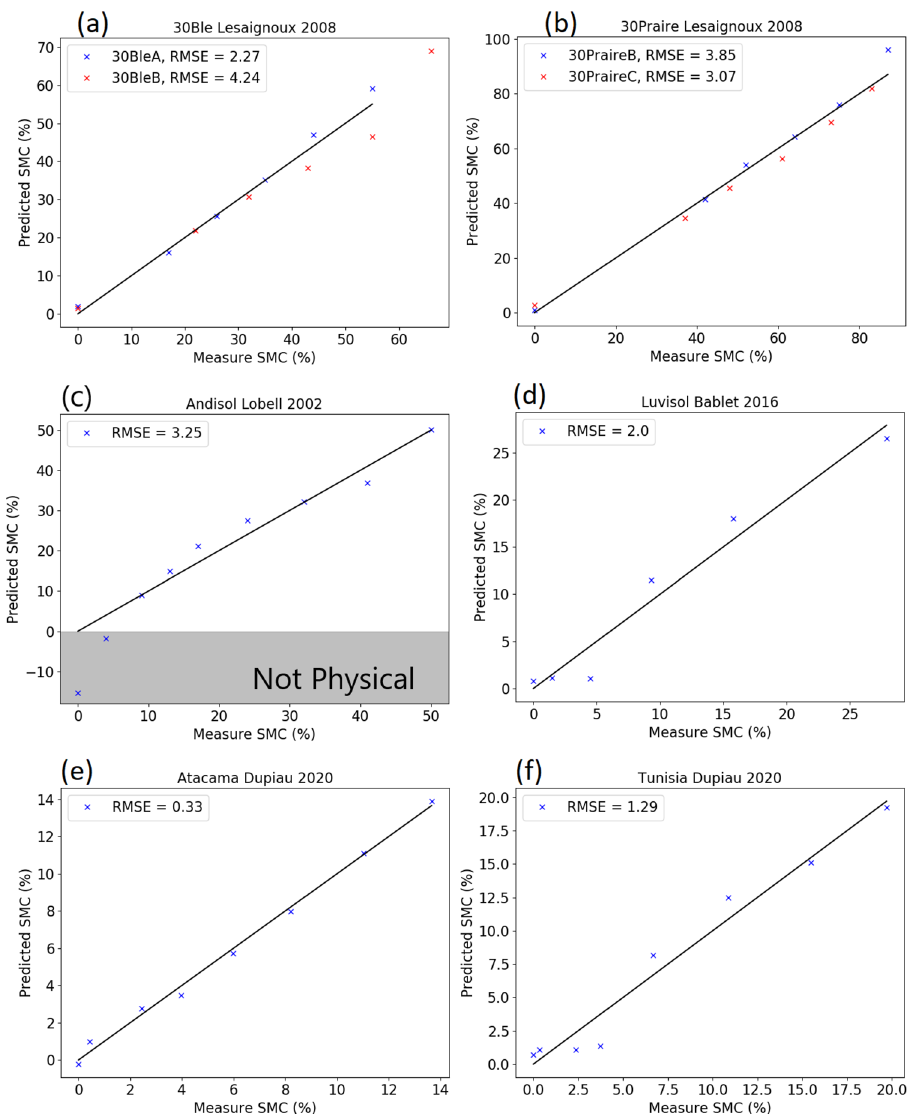
Figure 7. Predicted vs measured soil moisture content from calibration curves created in Fig.